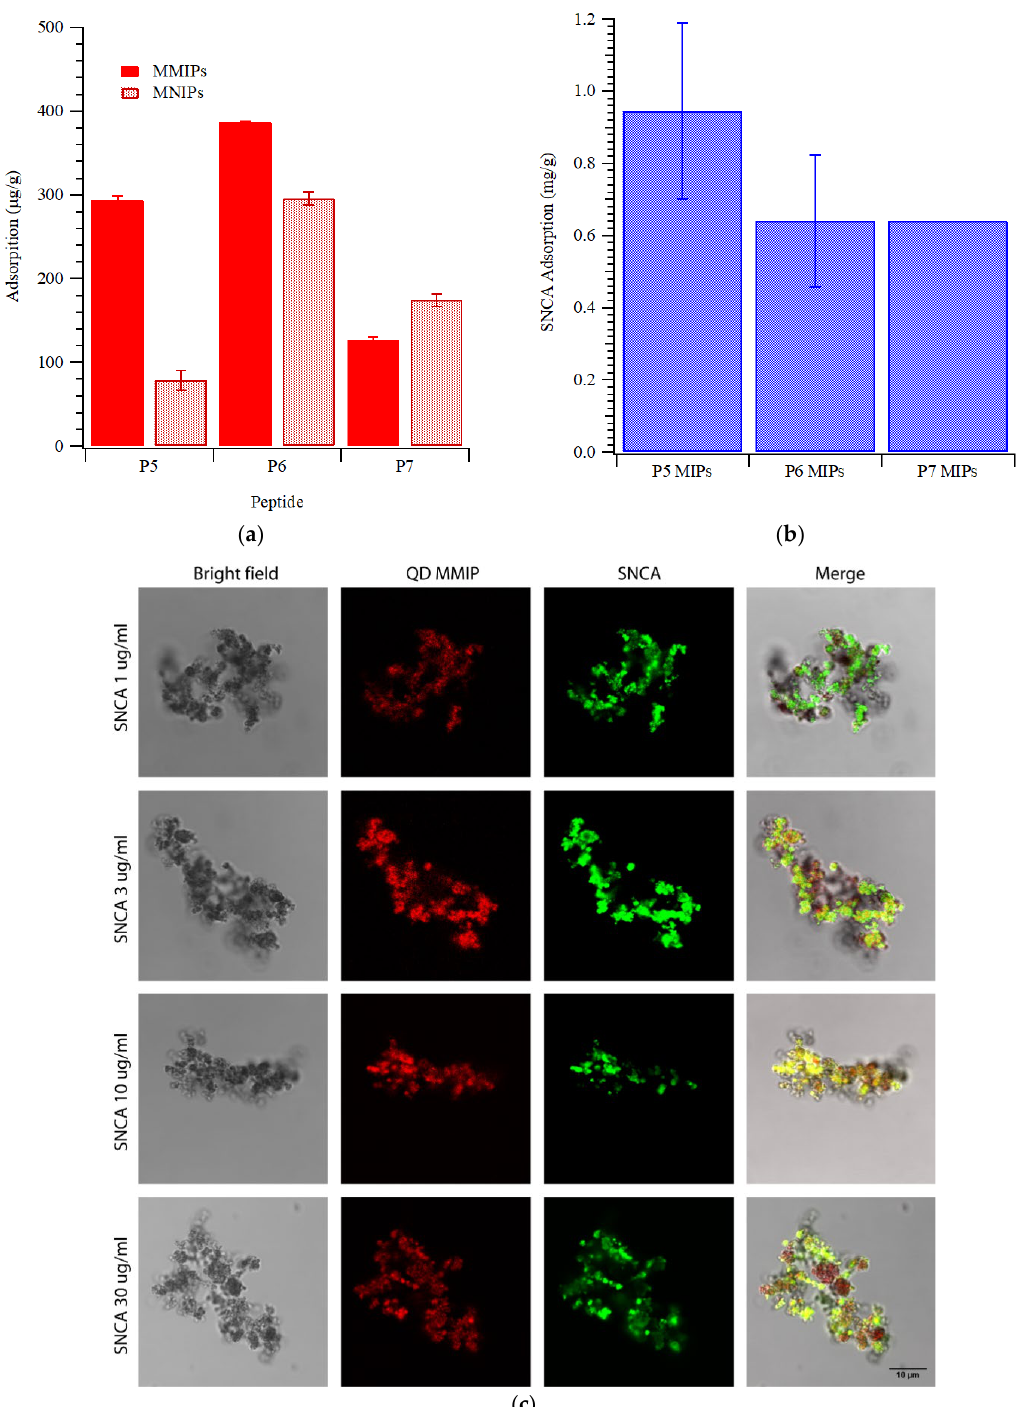
Figure 4. ( a ) Adsorption of P5, P6, and P7 on the P5 MMIPs and MNIPs. ( b ) Adsorption of P5, P6, and P7 on P5, P6, and P7 MMIPs, respectively. ( c ) Immunostaining for SNCA in quantum-dot- labeled SNCA recognizing magnetic nanoparticles (QD@MMIP). QD@MMIPs (100 µ g/mL)